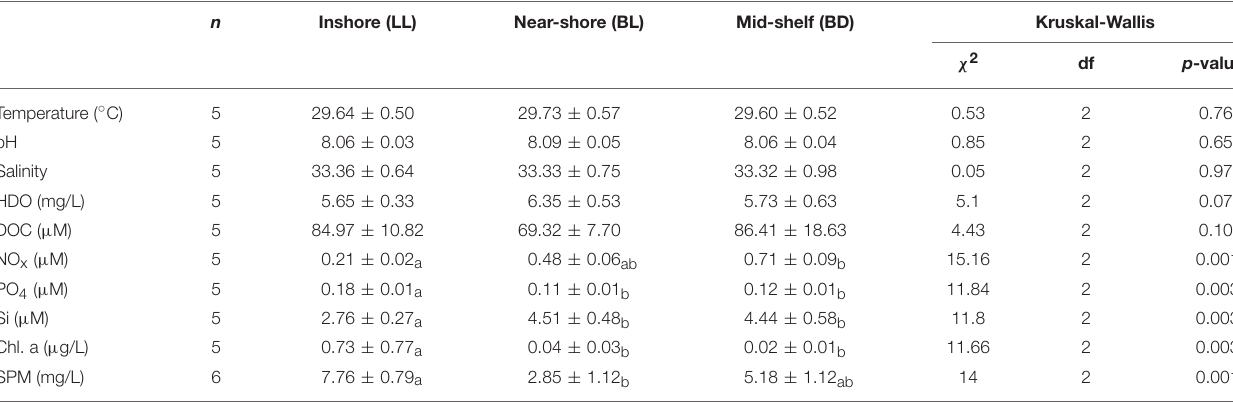
TABLE 1 | Environmental parameters at the three